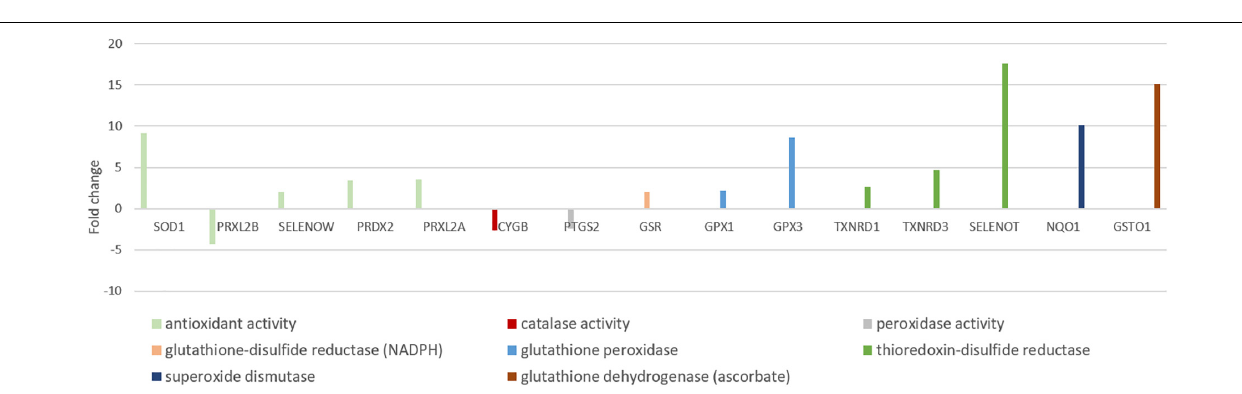
FIGURE 7 | Antioxidant genes differentially expressed in neurons of mouse and hooded seal visual cortex. Positive fold changes represent a higher expression in hooded seal neurons.